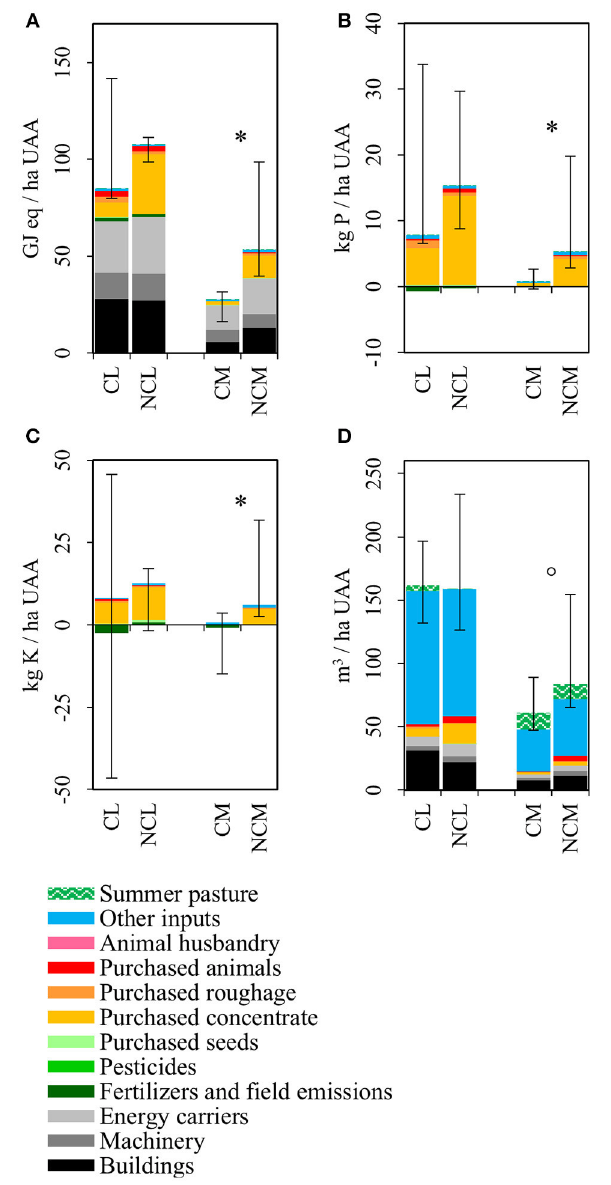
FIGURE 5 | Environmental impact per hectare usable agricultural area (ha UAA) for impact categories related to resource use: (A) non-renewable energy demand, (B) resource use, P extraction, (C) resource use, K extraction, (D) water use. Bars indicate the median performance of each farm group (CL, collaborating lowland farms; NCL, non-collaborating lowland farms; CM, collaborating mountain farms; NCM, non-collaborating mountain farms) and sources of impacts. Whiskers indicate the minimum and maximum impact within each group, *indicate significant differences between farm groups within a given region ( p < 0.05), ◦ indicate tendencies ( p ≤